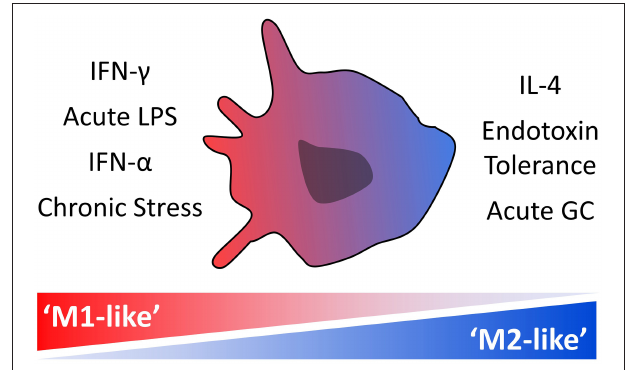
FIGURE 1 | Stimuli and physiological states associated with monocyte “M1-like” and “M2-like” phenotypes. Monocytes exist along a spectrum of activation states that are dependent on the overall combination of environmental signals, with specific transcriptional signatures indicative of a more proinflammatory “M1-like” phenotype and others of a more anti-inflammatory or protective “M2-like”